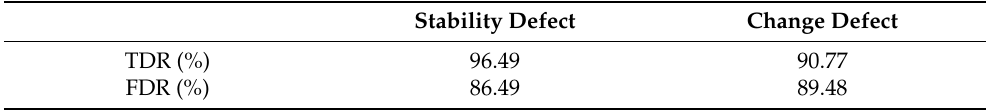
Table 1. Defect detection capabilities of our